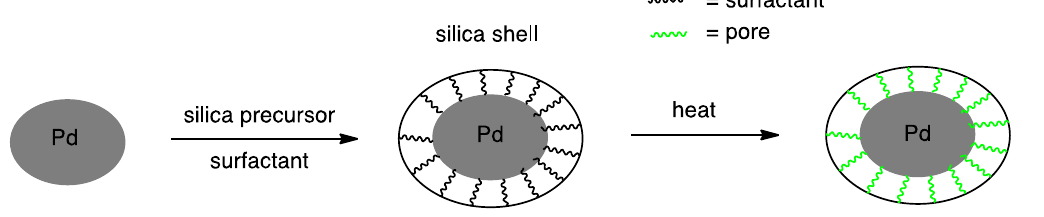
Figure 8. The process of core@shell structure formation.